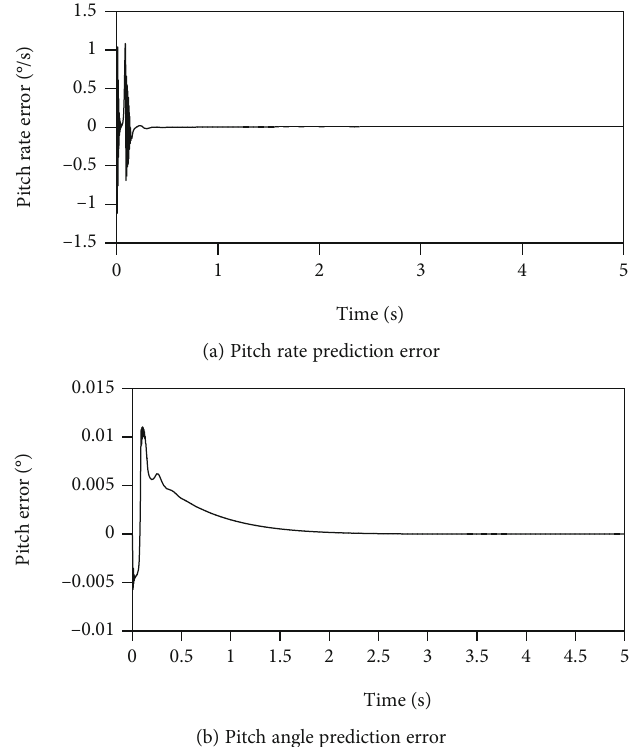
Figure 13: The state prediction error change curve of step